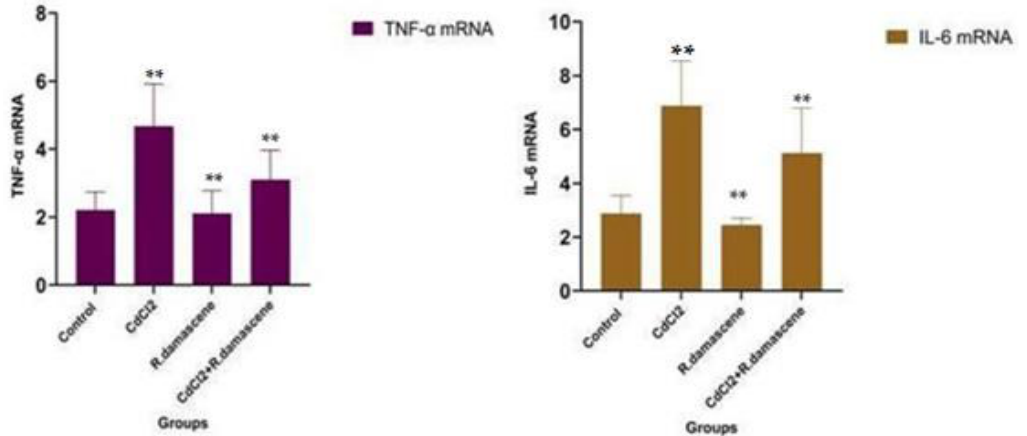
Figure 4. R. damascena leaves extract dose (100 mg.Kg −1 ) increased the expression of TNF- α and IL -6 in the hepatic tissues of CdCl 2 (5 mg/Kg)-exposed male rats. Data are expressed as mean±SE. ** means that the difference was highly significant ( p <0.01).